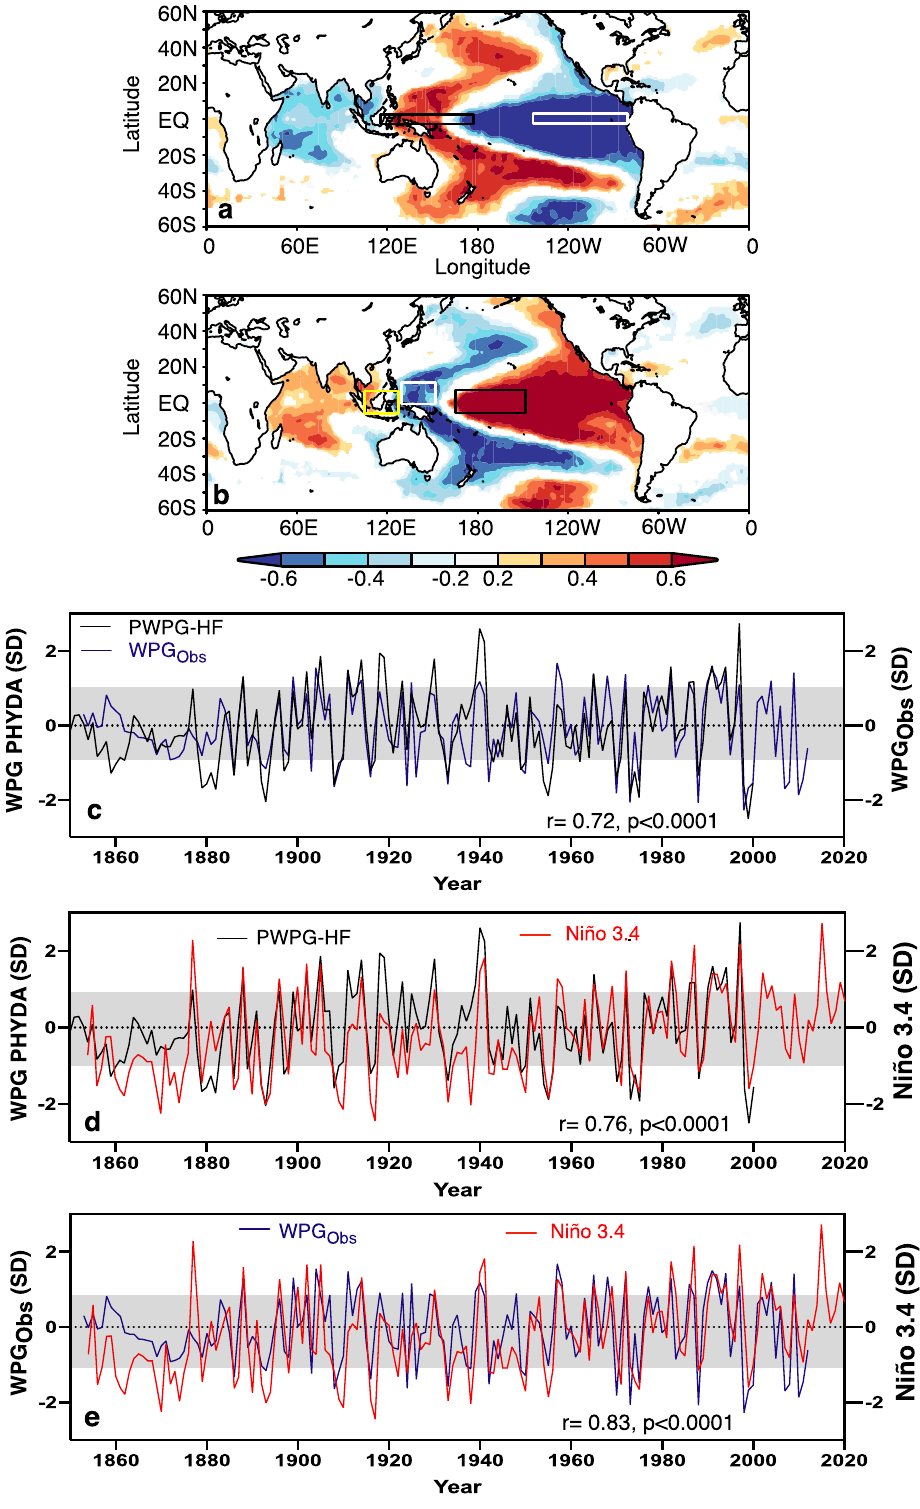
Figure 1. Zonal Pacific SST gradient (COBE 24 ) and West Pacific Gradient (WPG 24 ) correlation with HadISST 14 and WPG PHYDA reconstruction 34 . Time series were normalised relative to 1961–1990 (SD = standard deviation). ( a ) Zonal SST gradient from COBE2 57 following definition of Coats and Karnauskas 9 (SST difference between 2.5°N–S, 117°E–173°E and 2.5°N–S, 205°E–275°E; see rectangular boxes) correlated with HadISST and ( b ) WPG following definition of Hoell and Funk 24 correlated with HadISST (black and white box = WPG 24 ; yellow and black box = WPG 25 ). Spatial correlations in ( a ) and ( b ) computed in KNMI climate explorer 61 (https:// clime xp. knmi. nl/), only correlation at 95% level coloured. PHYDA-West Pacific Gradient (WPG) reconstruction with 1 SD (grey bar) compared with ( c ) observed WPG after 24 based on ERSSTv3b and ( d ) observed Niño3.4 index 2 and ( e ) observed WPG after 24 based on ERSSTv3b and observed Niño3.4 index 2 . Correlation coefficients (year to year) are indicated over full period of overlap for detrended